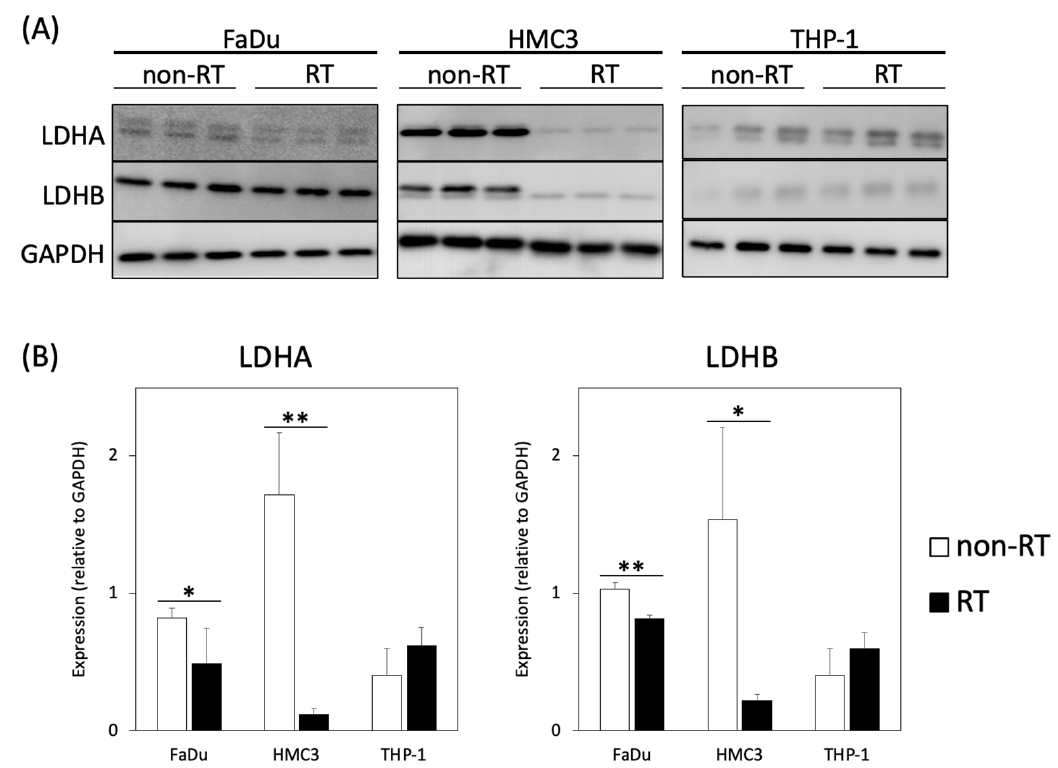
Figure 5. Analysis of the expressions of LDHA and LDHB in the non-irradiated (non-RT) and irradiated (RT) cancer and immune cells. ( A ) Western blot analyses of LDHA and LDHB in FaDu, HMC3, and THP-1 cells. GAPDH was used as a loading control. ( B ) Comparison of the expressions of LDHA and LDHB between the non-irradiated and irradiated cells (* p < 0.05; ** p < 0.01). Note—LDH, lactate dehydrogenase; GAPDH, glyceraldehyde-3-phosphate dehydrogenase.